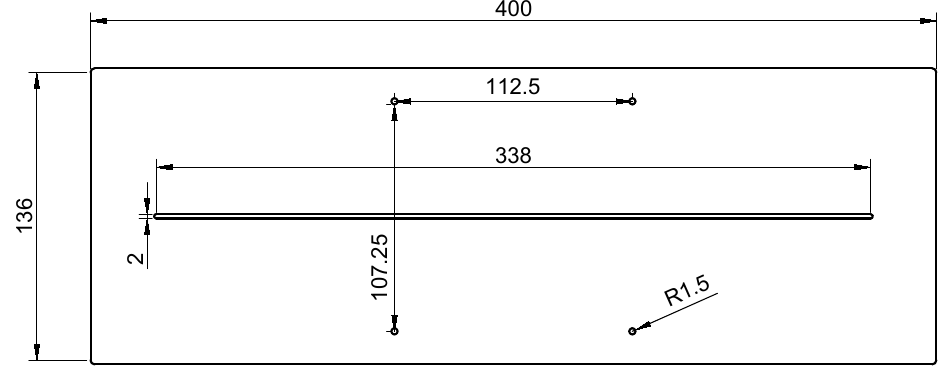
Figure A2. Dimensions of the ground plane. All dimensions are in mm. The thickness of the plate is 3